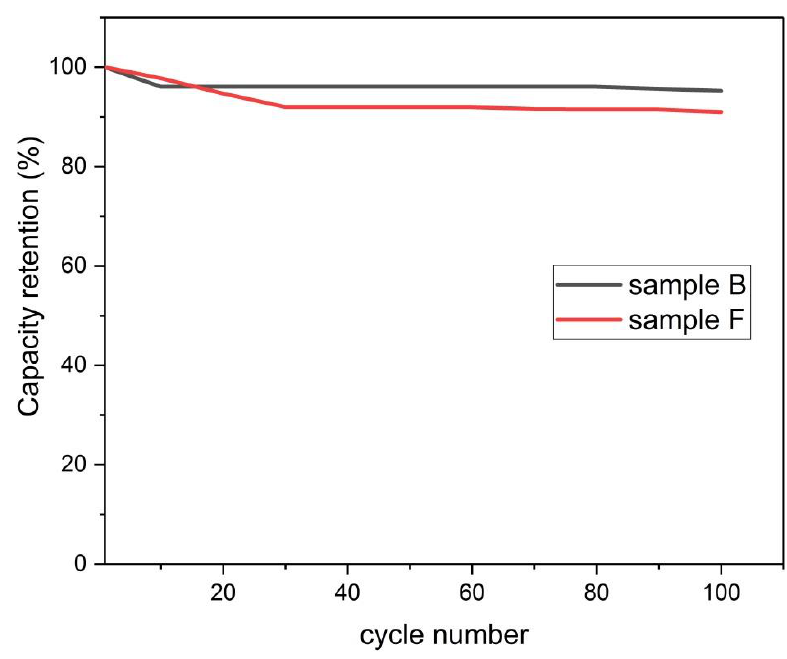
Figure 23. Capacity retention versus cycle number.